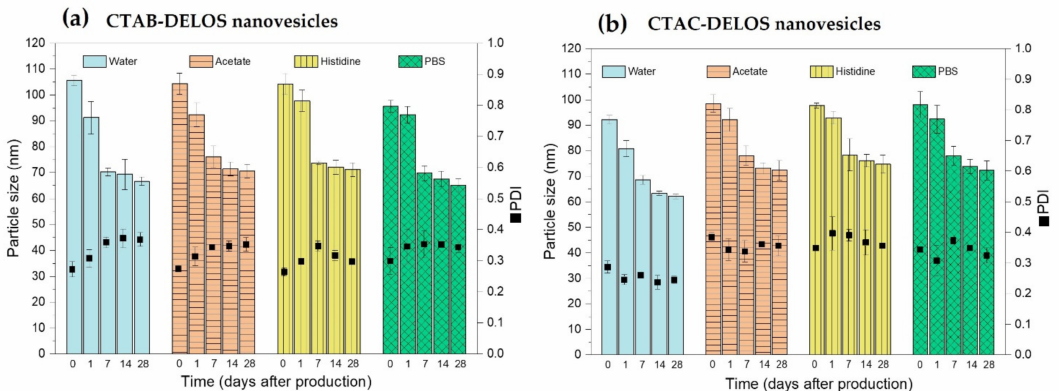
Figure 2. ( a ) Evolution of CTAB-DELOS nanovesicles and ( b ) CTAC-DELOS nanovesicles over time on particle size and polydispersity index (PDI) with the effect of different dispersant media: water (blue); 5 mM acetate, pH = 5.0 (orange, horizontal line); 5 mM histidine, pH = 7.0 (yellow, vertical line); and 5 mM PBS, pH = 7.4 (green,